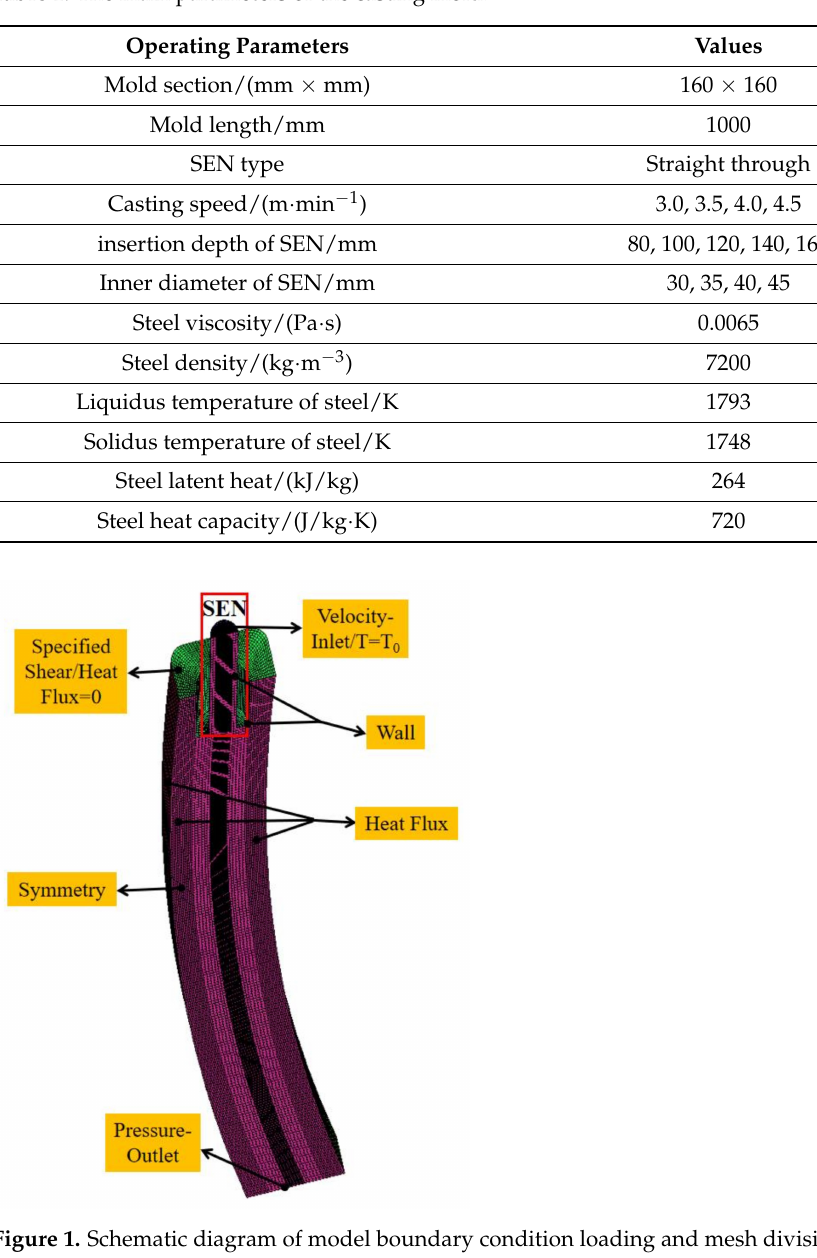
Table 1. The main parameters of the casting mold.